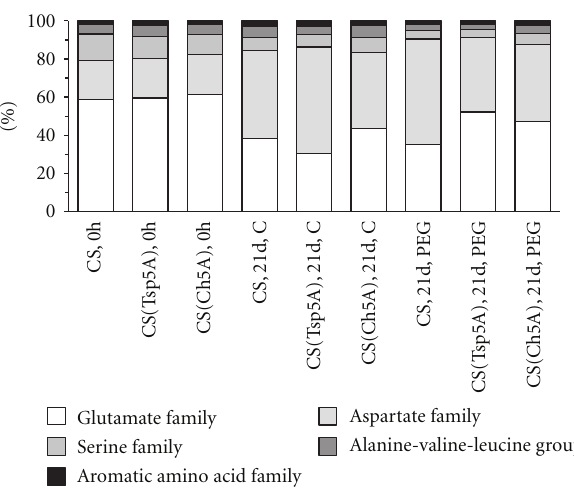
Figure 3: Changes in the ratio of amino acid families during osmotic stress. A comparison was made of the freezing-sensitive CS and CS(Tsp5A) and the freezing-tolerant CS(Ch5A) wheat geno- types, grown for three weeks under control (C) or stress conditions (15% PEG). The experiment was repeated with three parallels three times with similar